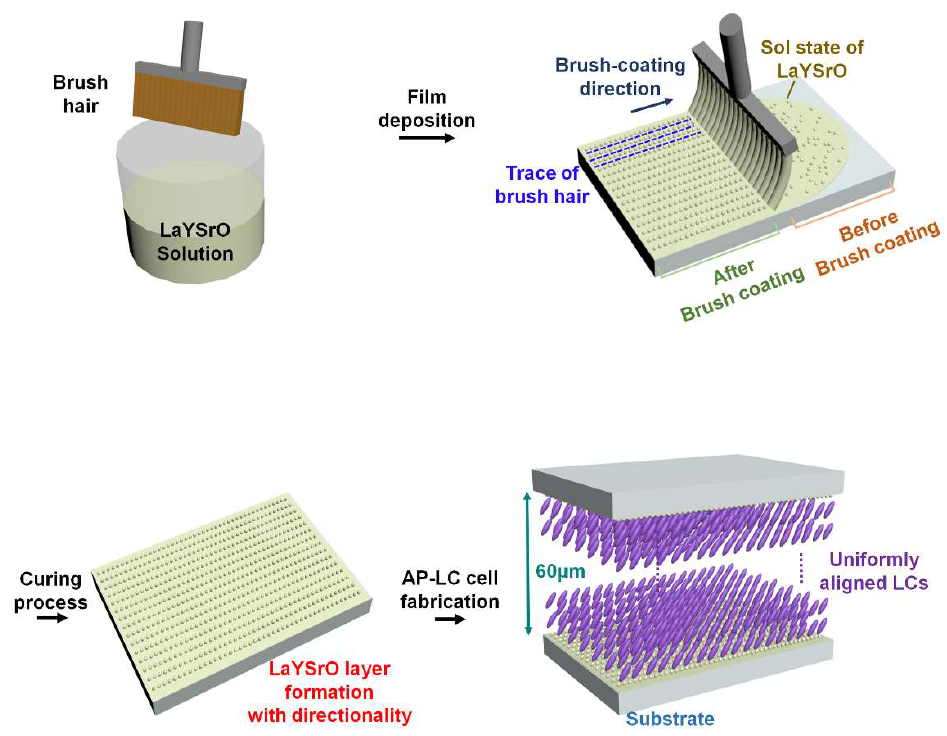
Figure 1. Illustration of the brush-coating process for the LaYSrO solution and the fabricated AP-LC cell. During the coating process, the sol state of the LaYSrO was oriented along the coating direction. Before and after brush-coated regions are presented for intuitive comparison. AP-LC cells with 60 μm cell gap were fabricated based on the directional LaYSrO layer and expected to show uniform alignment of the LCs.